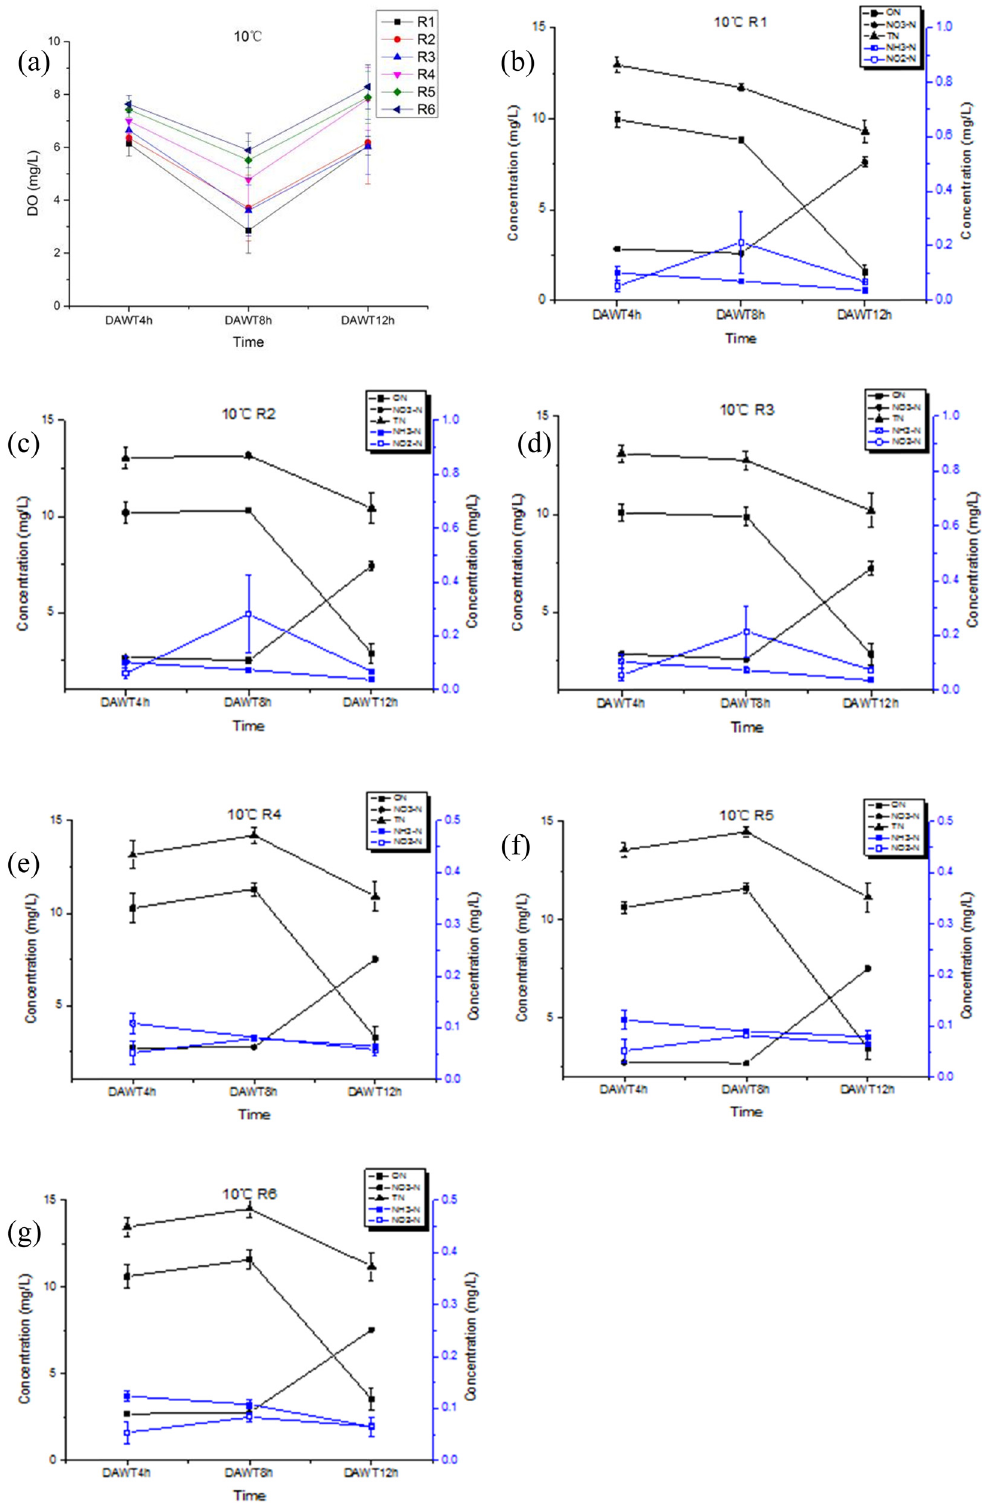
Figure 7: DO and N varies with DWAT: ( a ) the DO of R1 – R6 varies with DWAT, ( b – g ) the nitrogen elements of R1 – R6 varies with